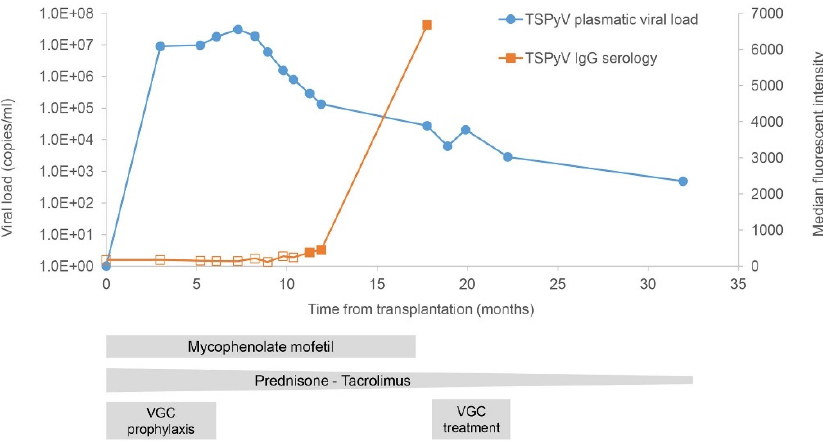
Figure 2. Trichodysplasia spinulosa polyomavirus (TSPyV) real-time PCR results in plasma samples and IgG seroreactivity over time after kidney transplantation. Empty and plain squares represent IgG seronegativity and seropositivity, respectively. VGC: valganciclovir.